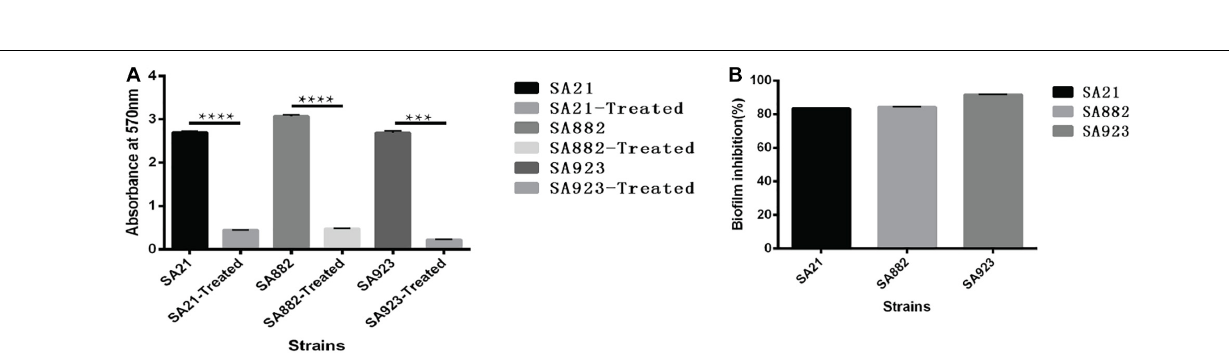
FIGURE 2 | Growth curves of S. aureus strains cultured with ZY-214-4. TSB served as a blank control, and growth in the presence of DMSO was evaluated to eliminate the possibility that inhibition of biofilm formation is due to suppression of cell growth.